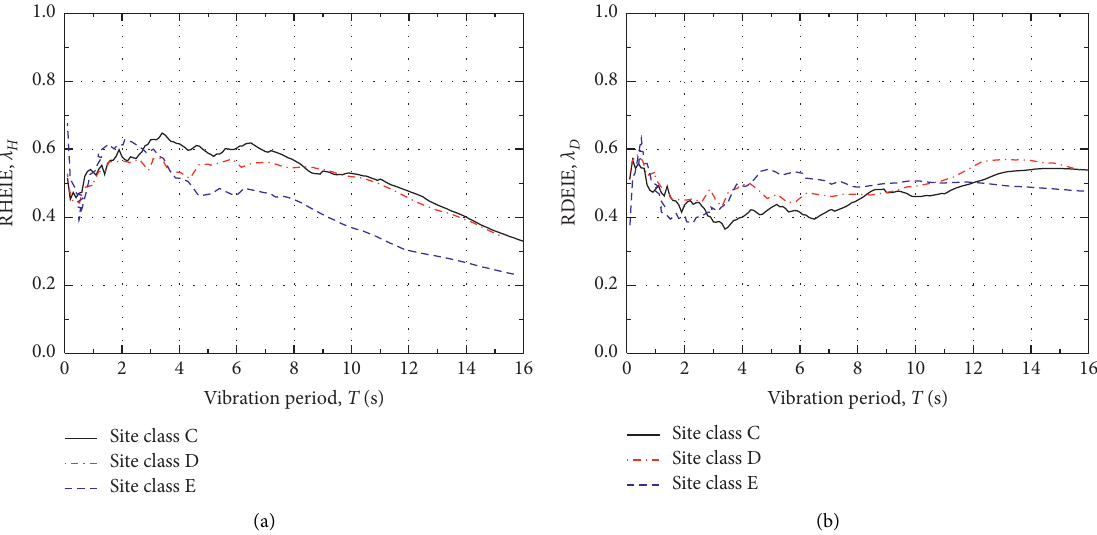
Figure 12: Energy distribution rule affected by site class under far-field harmonic ground motions. (a) (a) RHEIE. (b) RDEIE.